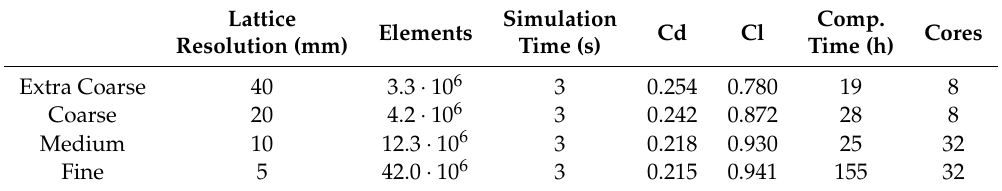
Table 6. Grid independence with configuration A / c = 0.025 and λ / c = 0.2 at α = 18